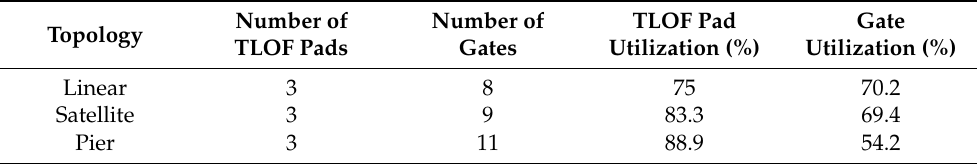
Table 9. Results of each topology for the expanded Gimpo parking lot space that complies with the FAA’s new